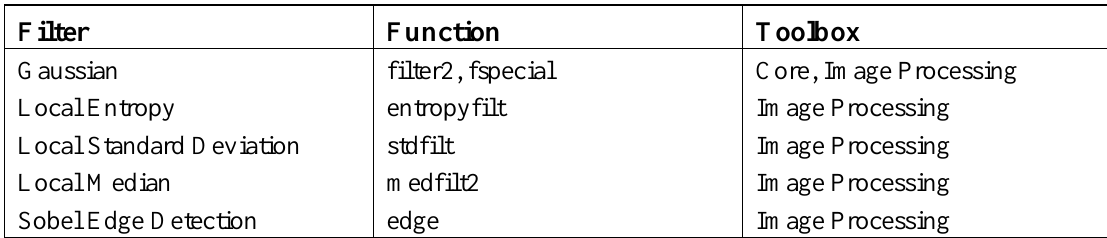
Table 2. Feature extraction filters, the Matlab functions in which they are implemented, and the toolbox which contains